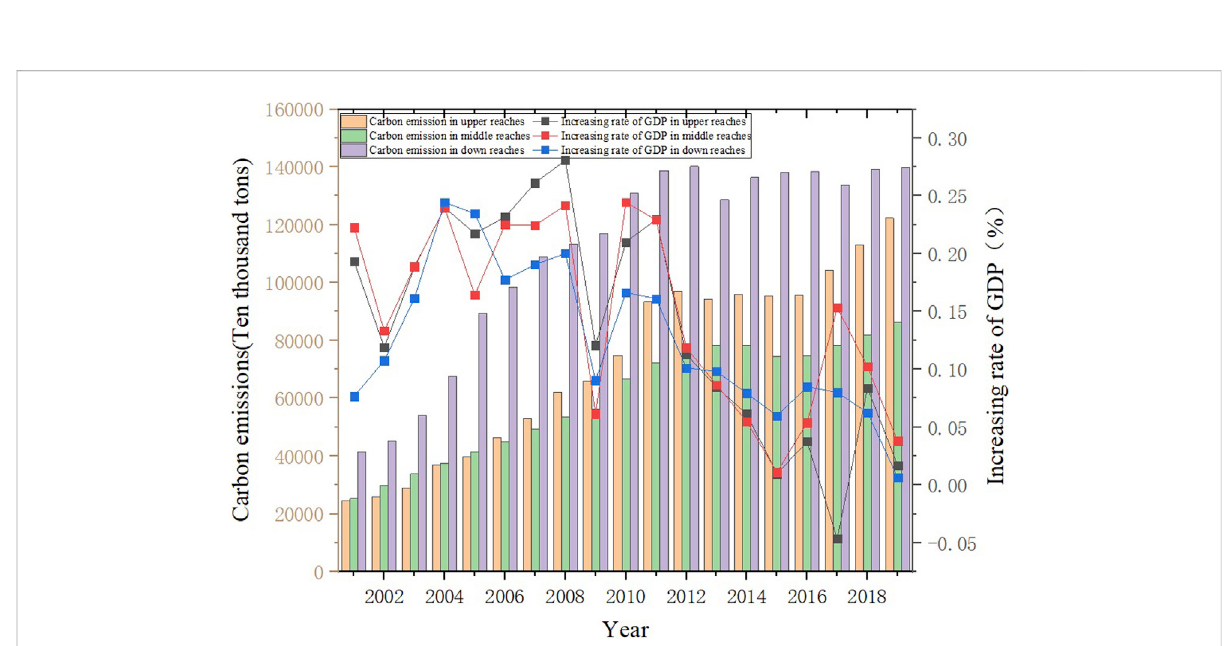
FIGURE 5 Carbon emission and economic growth of various regions in the